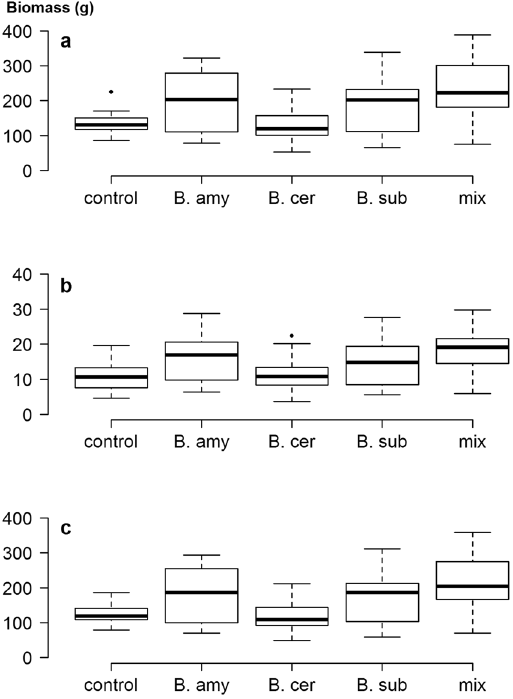
Figure 5. Box plots showing the range in size distributions for ( a ) total biomass, ( b ) root biomass and ( c ) shoot biomass of calabrese plants grown in Indian field soil, with and without the addition of plant growth-promoting